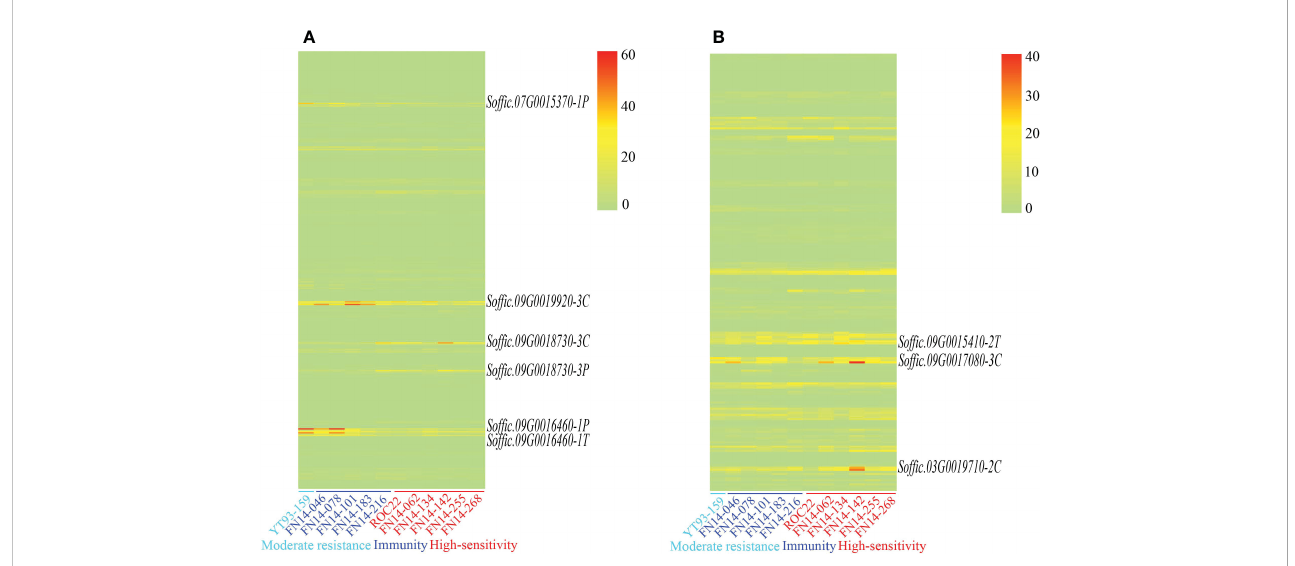
might play a role in rice stripe resistance. Chang et al. (2022) found a FKBP-type peptidyl-prolyl cis-trans isomerase (PPIase) could interact with the motor protein of Tomato leaf curl New Delhi virus , and its transient overexpression reduced the virus replication. Aparicio and Palla ́ s (2017) con fi rmed that bHLH transcription factor can promote salicylic acid-dependent defense signaling by interacting with the Alfalfa mosaic virus CP protein. Studies have also shown that MdMYB73 can improve apple ’ s resistance level to Botryosphaeria dothidea through the salicylic acid pathway (Gu et al., 2020). The